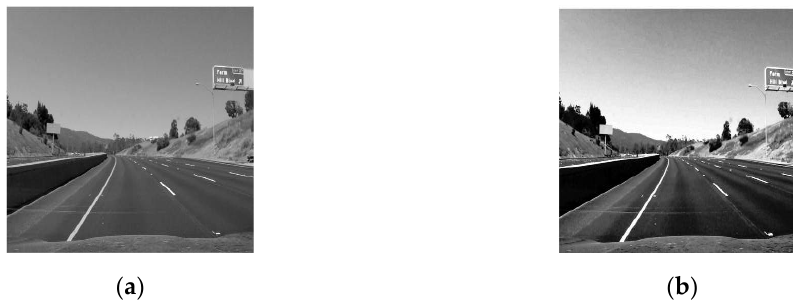
Figure 1. Effect of histogram equalization processing: ( a ) Before processing; ( b ) After processing.